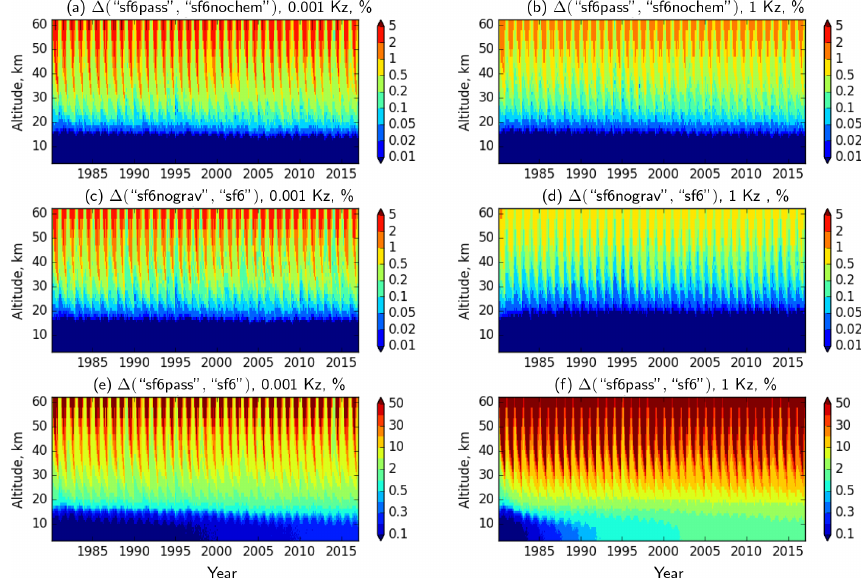
Figure 4. The relative reduction of the SF 6 content (in %) at 70–85 ◦ S due to gravitational separation with (a, b) and without (c, d) depletion and due to the combined effect of depletion and separation (e, f) at two extreme Kz cases. Note the different colour scales for (e) and (f)